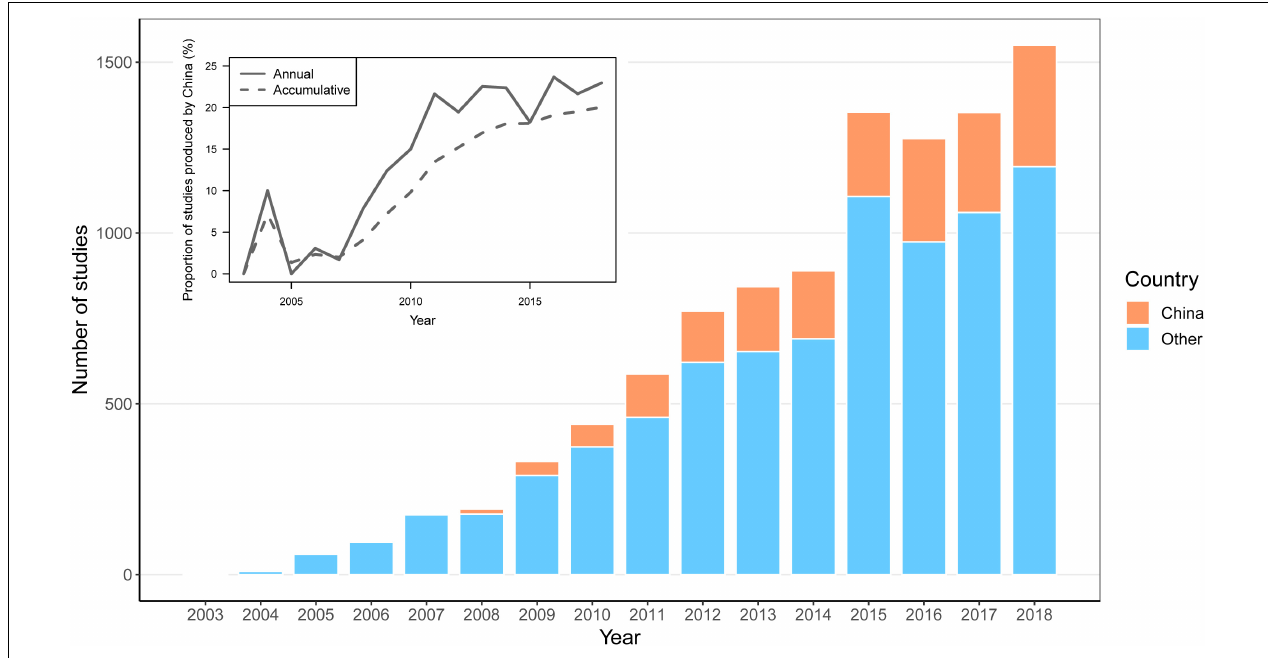
FIGURE 3 | Numbers of articles published on DNA barcoding by Chinese scientists and researchers from all other countries between 2003 and 2018. The X axis gives the year of publication, and the Y axis indicates the number of studies. Orange bars represent the number of articles published by Chinese scientists, while blue bars indicate the number of articles published by other researchers from all other countries. The small figure in the upper left corner represents the proportion of the number of articles from Chinese studies to the total number of articles, where the solid line represents the proportion of articles contributed by Chinese scientists to all others each year, and the dotted line represents the proportion of accumulated articles to all